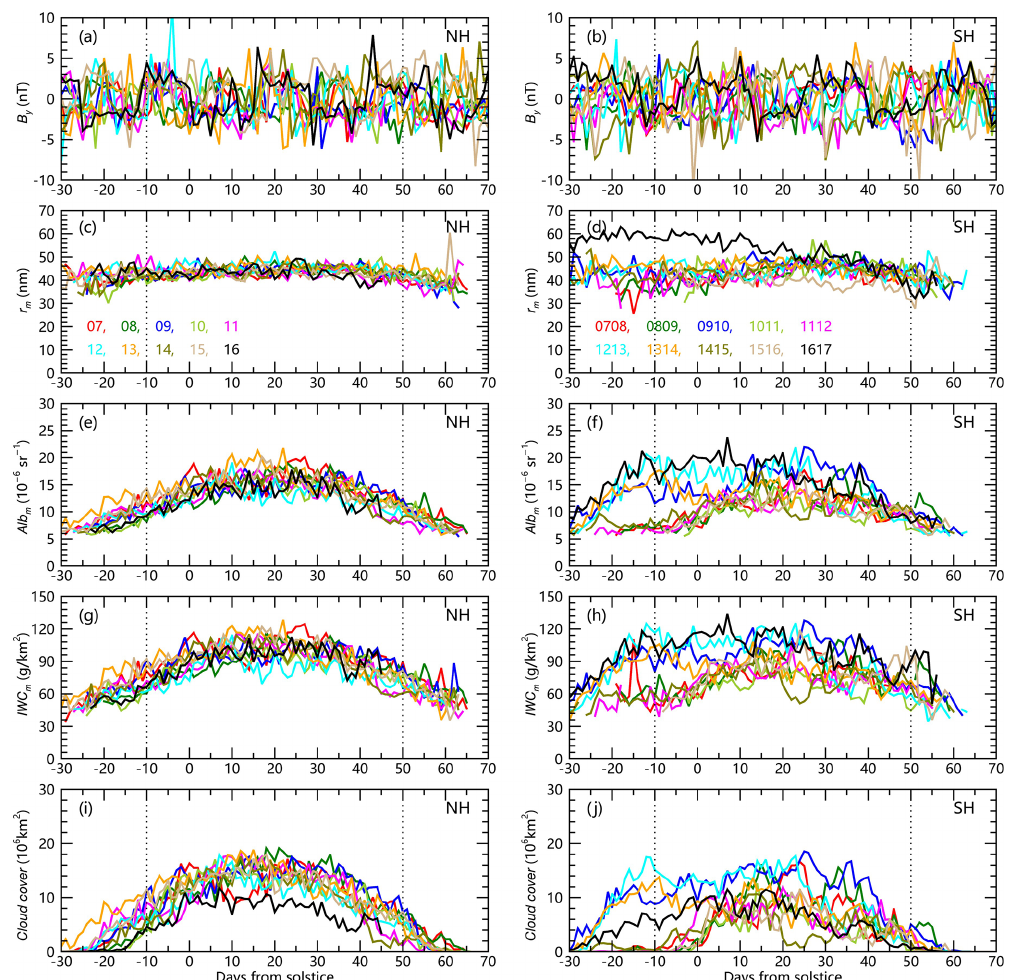
Figure 1. Daily averaged IMF B y , mean ice particle radius ( r m ), mean albedo (Alb m ), mean ice water content (IWC m ) and cloud cover observed by CIPS for the NH (a, c, e, g, i) and SH (b, d, f, h, j) for each of the NLC seasons from 2007 through